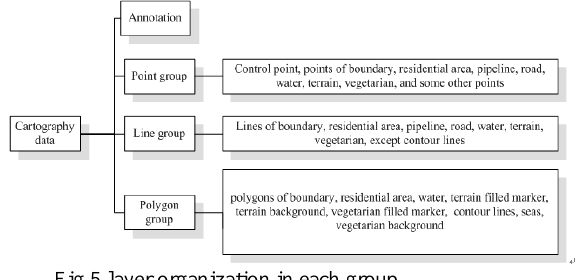
Fig.5 layer organization in each